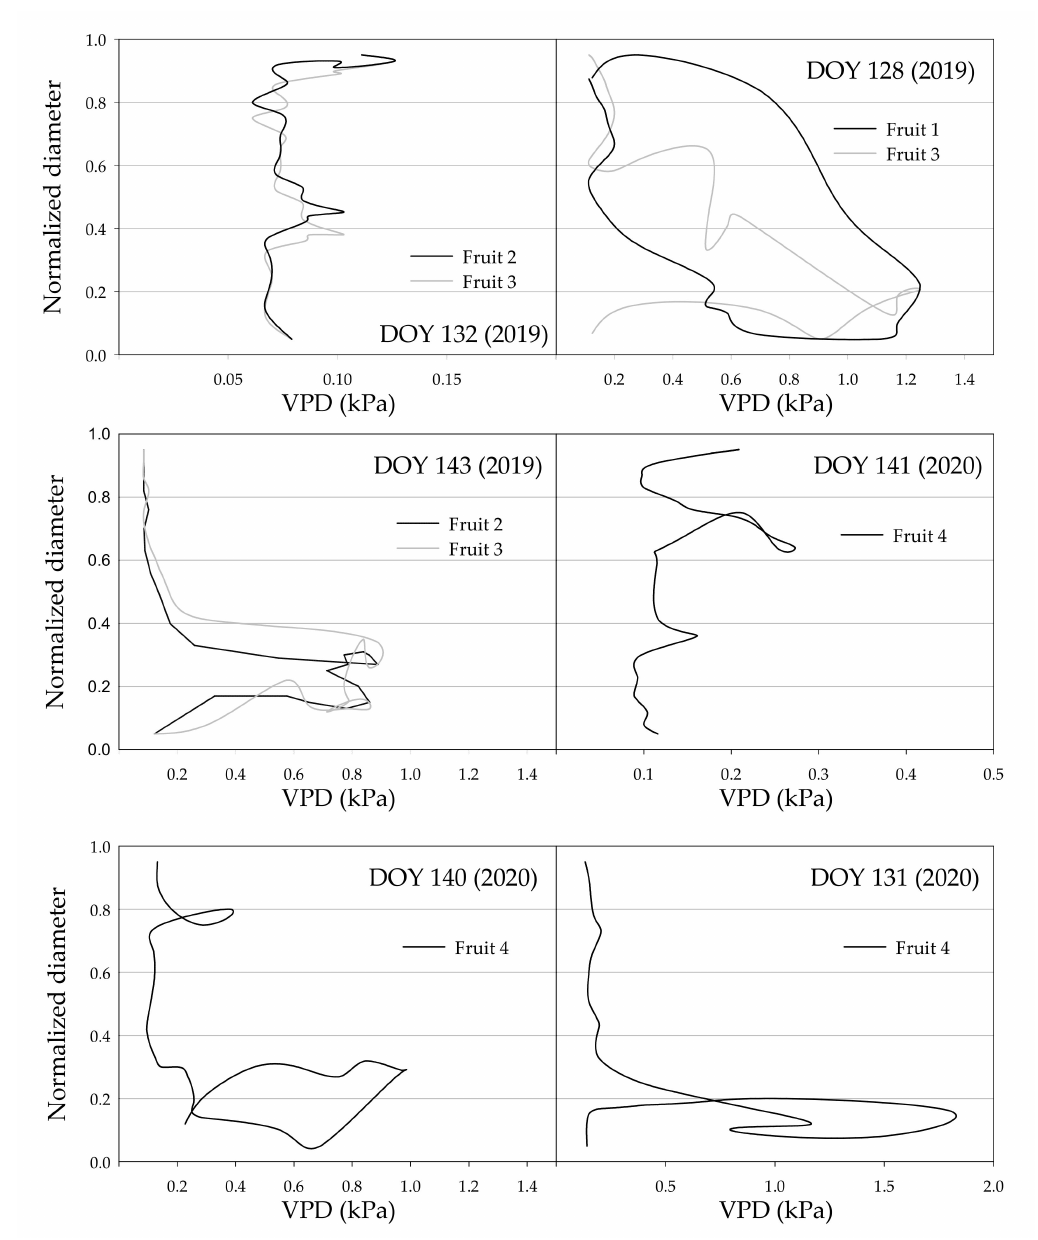
Figure 5. Most representative relations between VPD and transversal diameter in fruit growth stage 3 in 2019 and